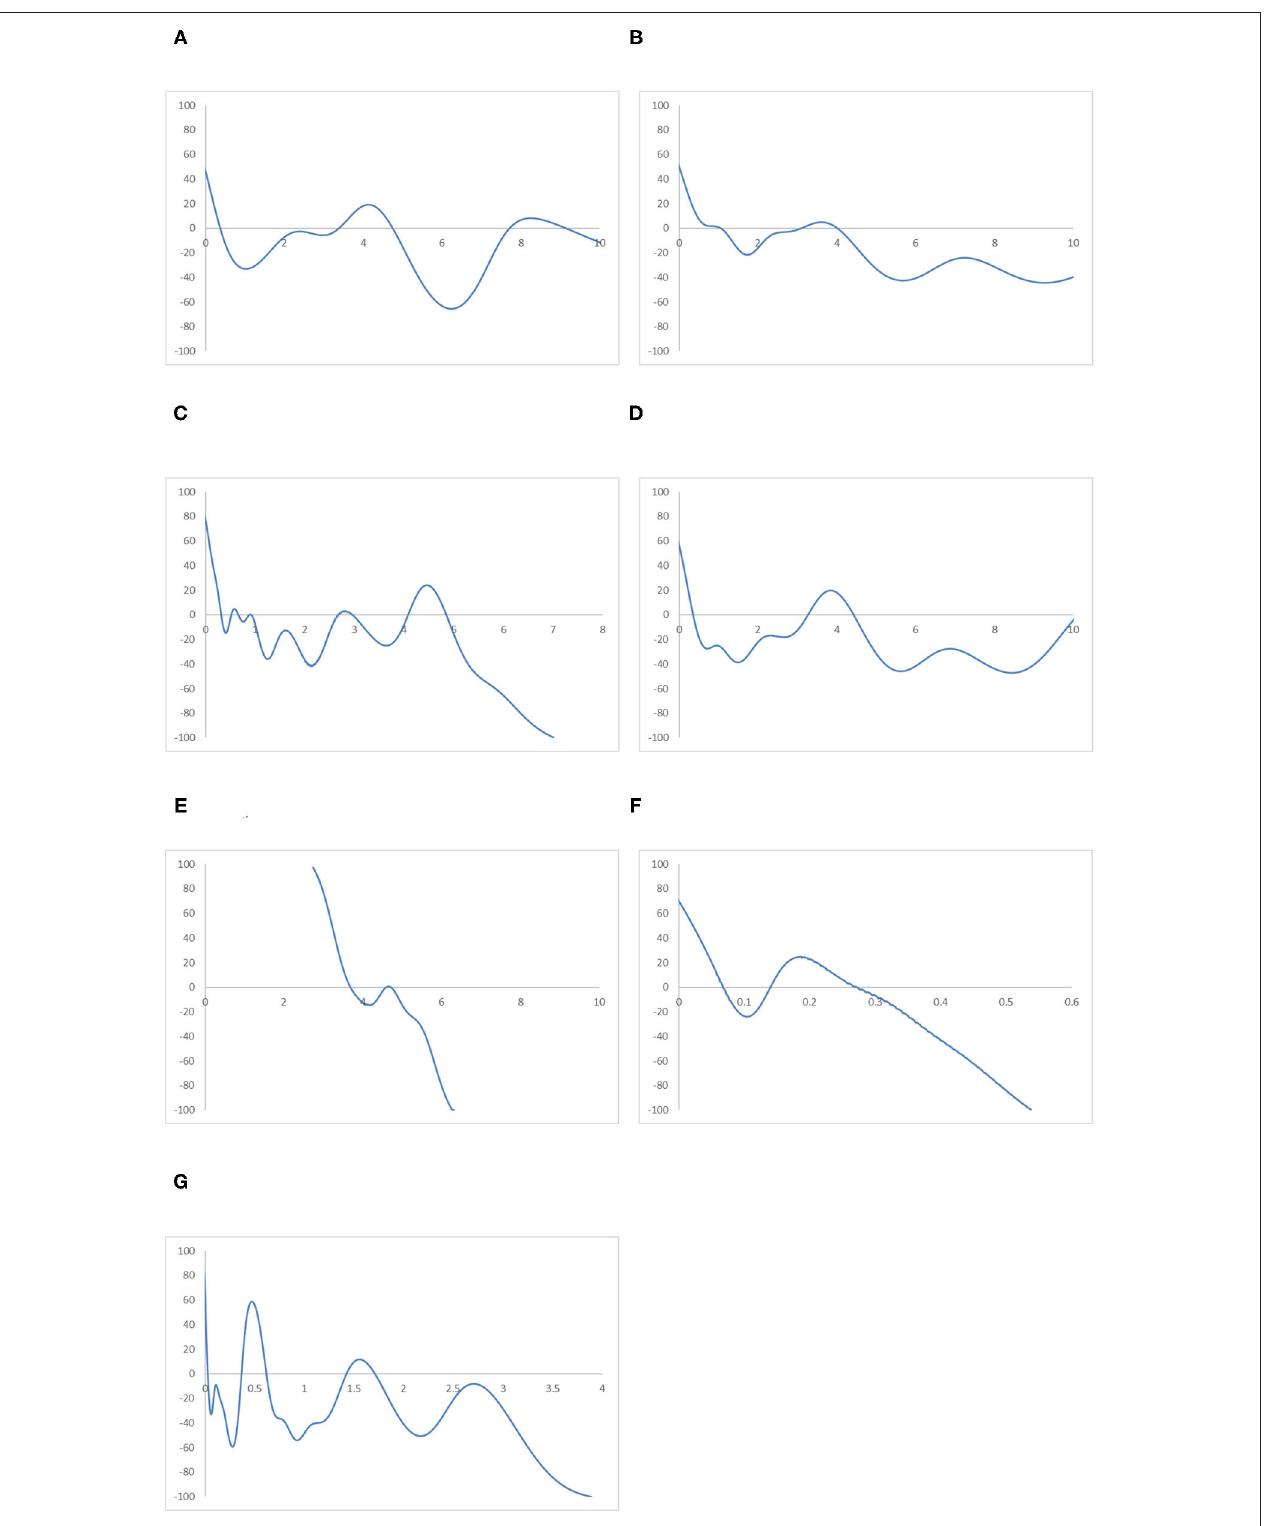
FIGURE 12 | Mobility probability plot (MPP) for the RIVAPC of countries for different geographical regions. Source: authors’ calculation. N.B. The vertical axis indicates net upward mobility (%) and the horizontal axis indicates RIVAPC values. (A) East Asia and Pacific. (B) Europe and Central Asia. (C) Latin America and Caribbean. (D) The Middle East and North Africa. (E) North America. (F) South Asia. (G) Sub-Saharan Africa.